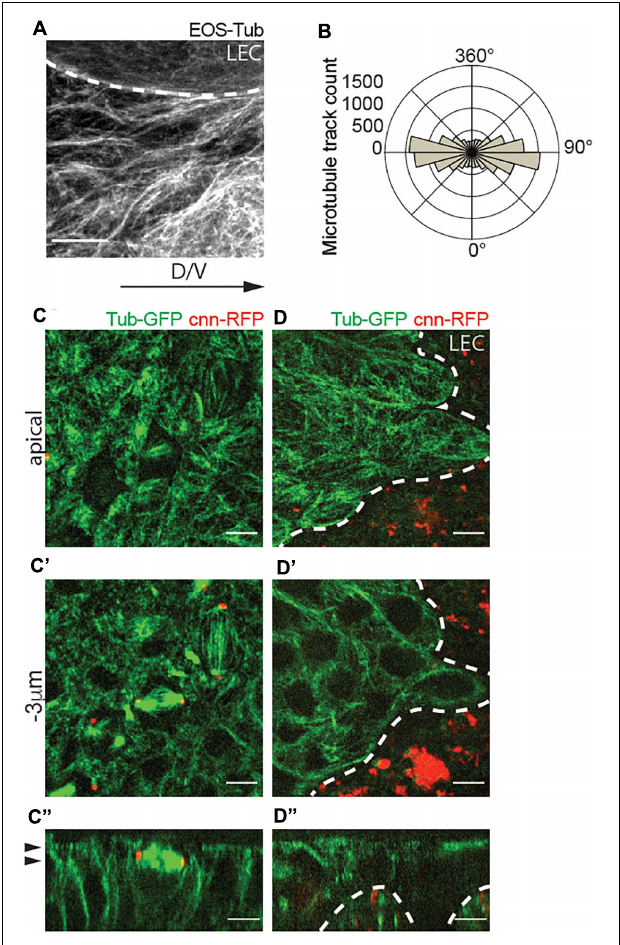
FIGURE 2 | Apical non-centrosomal microtubules in histoblast are aligned along the axis of migration (dorso-ventral axis). (A) Live fluorescence images of microtubules in wild-type histoblasts labeled with Tub-EOS. Scale bar = 5 µ m. (B) Microtubule growth track polarity in a cell. Polar plots indicate the counts (frequency of microtubule tracks) of microtubules growing in a cell along the longer axis of the cell. Number of microtubules ( n ) = 13,208, cells ( n ) = 28, and pupae ( N ) = 3. (C–D”) Confocal sections of abdomen showing histoblast expressing Tub-GFP (green) and the centrosome marker Cnn-RFP (red) during the initial phase of spreading (C–C”) and later active migration phase (D–D”) . Panels are showing the apical cross-sections (C,D) , cross-section 3 µ m bellow the apical side (C’,D’) , and orthogonal views of the histoblasts (C”,D”) . A white dashed line is marking the border between histoblasts and larval epidermal cells (LECs) (A,D–D”) , and the black arrowheads are marking the position of the cross-section plane in [top in panels (C,D) , and bottom in panels (C’,D’) ]. Note that interphase histoblasts do not have functional centrosomes. Scale bar (C–D”) , 5 µ m.